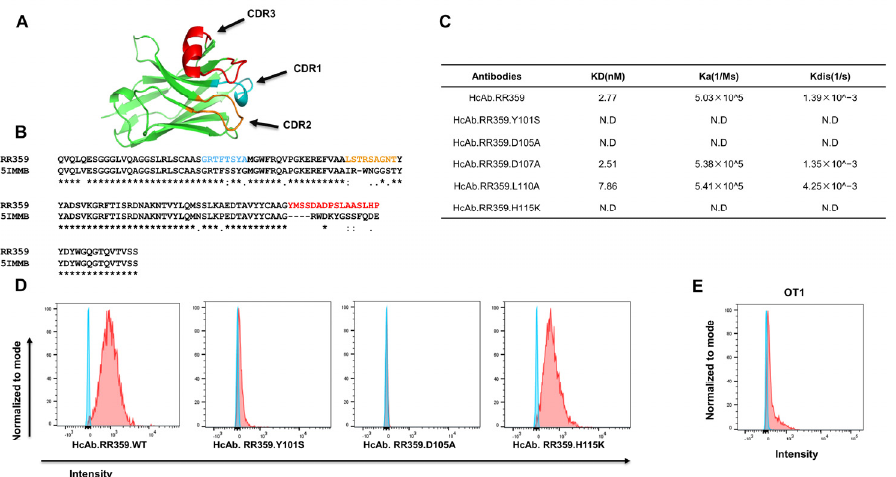
Figure 3. Generation of bispecific negative control antibody by CDR3 mutagenesis. ( A ) Structure of anti-mEGFR sdAb (RR359) predicted by ColabFold. ( B ) The sequence of anti-mEGFR sdAb (RR359) aligned to sdAb (5IMMB). The sequence of CDR1 (blue), CDR2 (orange), CDR3 (red) was indicated. ( C ) The affinity of mutated anti-mEGFR HcAbs measured by Octet. ( D ) The binding of mutated mEGFR HcAbs to CHO/mEGFR cell line. ( E ) TbsAb.con (mCD3E x mEGFR.D105A) binds to OT-1 cells detected by flow cytometry. N.D, not detectable. The “*” (asterisk) indicates positions with conserved residues. The “:” (colon) indicates conservation between groups of amino acids with similar properties. The “.” (period) indicates amino acids with weakly similar properties.